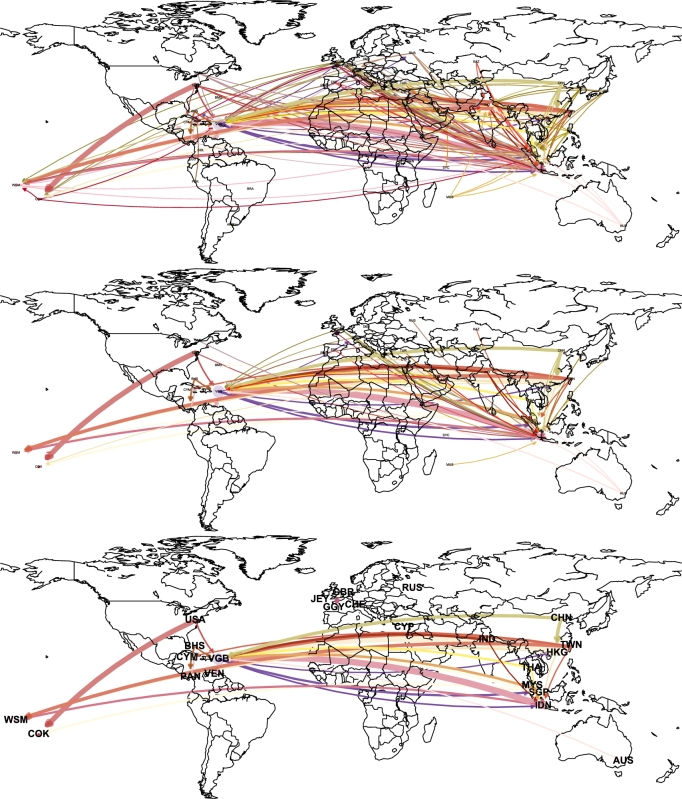
Geographic representation of offshoring countries and their relationships. From top to bottom, edge are trimmed for weights below thresholds: θ = {0.5,1.5,2.5}.